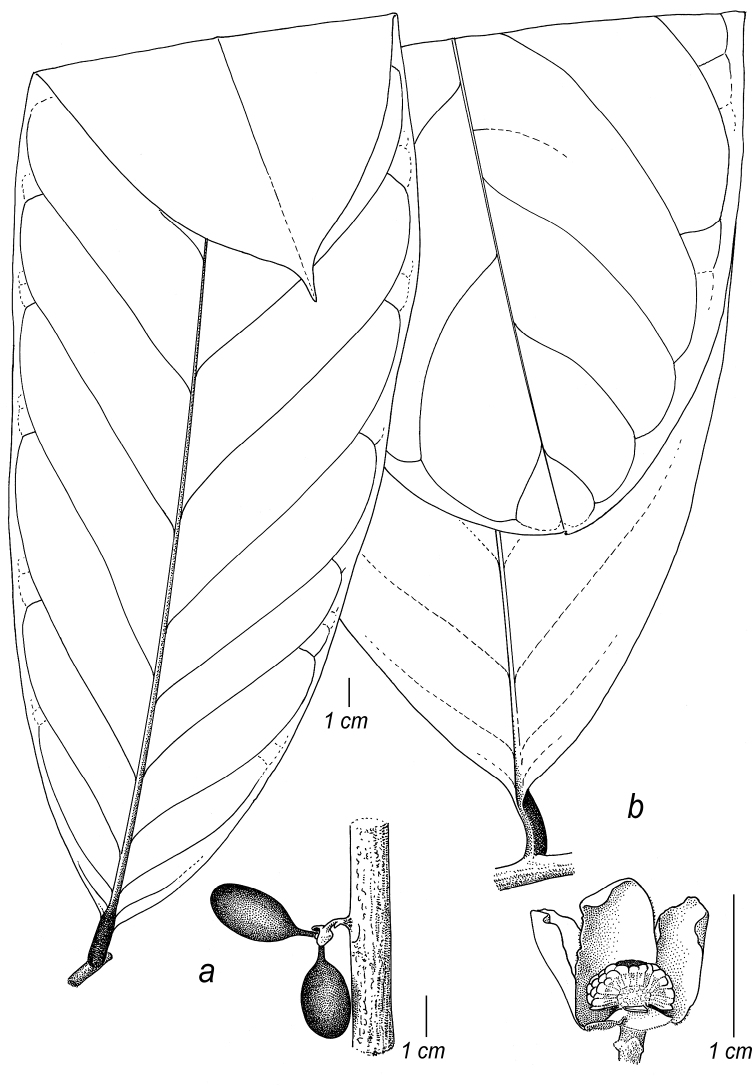
Cremastospermawestrae Pirie. a fruit and leaf (acuminate apex) b flower and leaf (apex broken off) (ade Nevers 4475bLiesner 682).